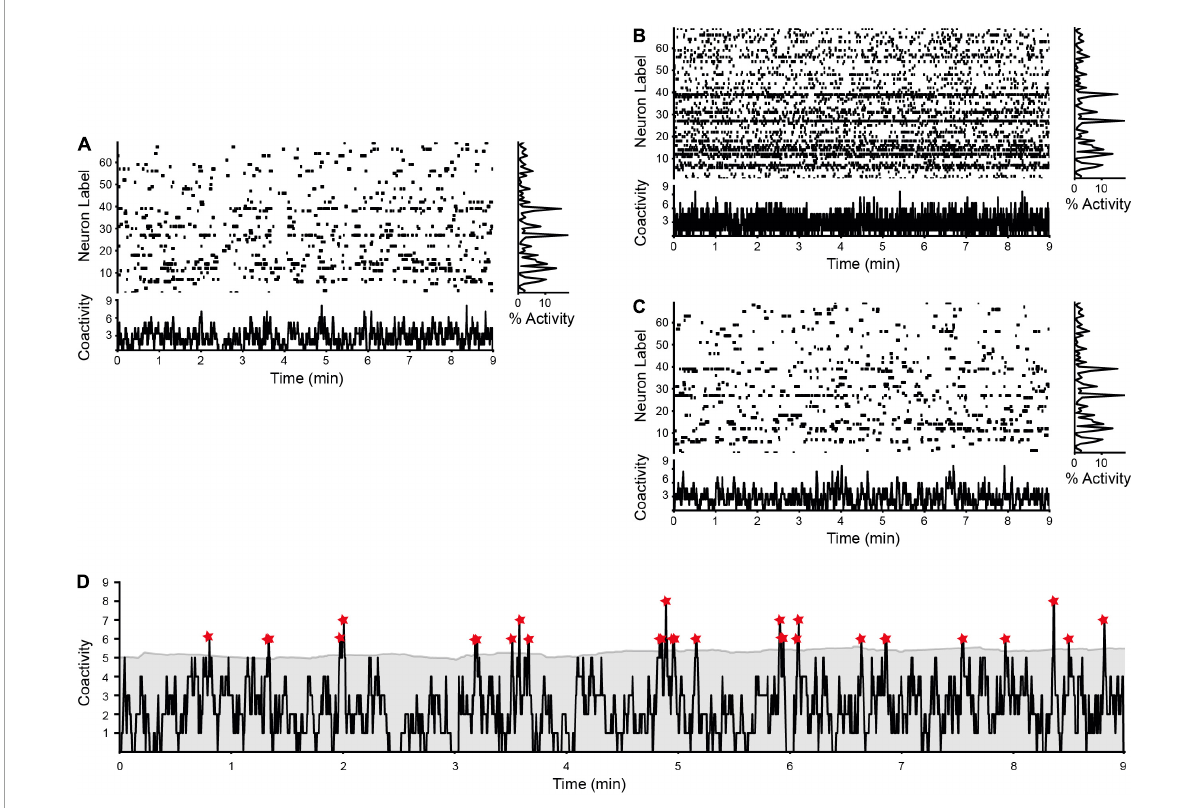
FIGURE4 Determining significant coactivity peaks. (A) Raster plot and histogram of coactivity. Neuronal activity exhibits a unique space-time structure. (B) Plot of a representative surrogate neuronal raster obtained by maintaining the number of neurons, time, and number of firings of each one, but randomly permuting their activity on the x -axis. The coactivity histogram (bottom) shows a different pattern with respect to that observed in experimental data. However, note that the activity graph (at right) remains intact, revealing that the same level of neuronal activity is present. This class of shuffled raster plots the probability of executing a type 1 error as evaluated with a corresponding Runs test. (C) Another class of surrogate raster plot maintains neuronal activity with the same restrictions as in panel (B) , but with the same distribution of intervals between active moments after the random permutation. The pattern of coactivity determined through this process is like the one observed in the experiment. This yields a surrogate raster that is hard to distinguish from the experimental one. This surrogate raster plot is used to evaluate type 2 error with a corresponding Runs test. (D) Once shown that the experimental coactivity signal is not a product of chance, the significant values of coactivity are determined with a sliding window equal to “ n ” standard deviations (regularly n ≥ 2). A dynamic threshold is used to capture significant coactivity peaks. Asterisks indicate the time periods when the coactivity exceeds the threshold